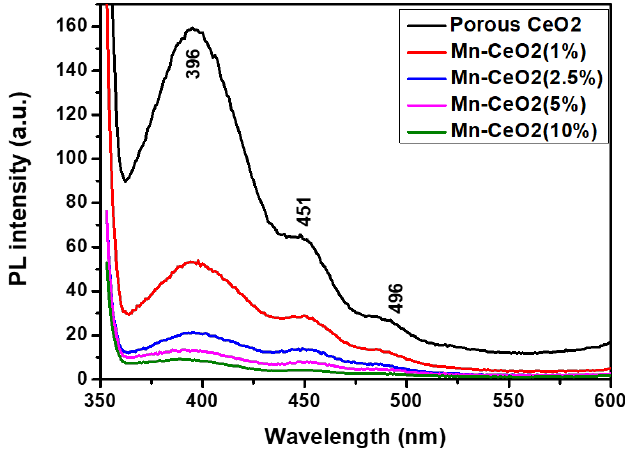
Figure 11. The spectra of CeO 2 at different amounts of Mn doping level.